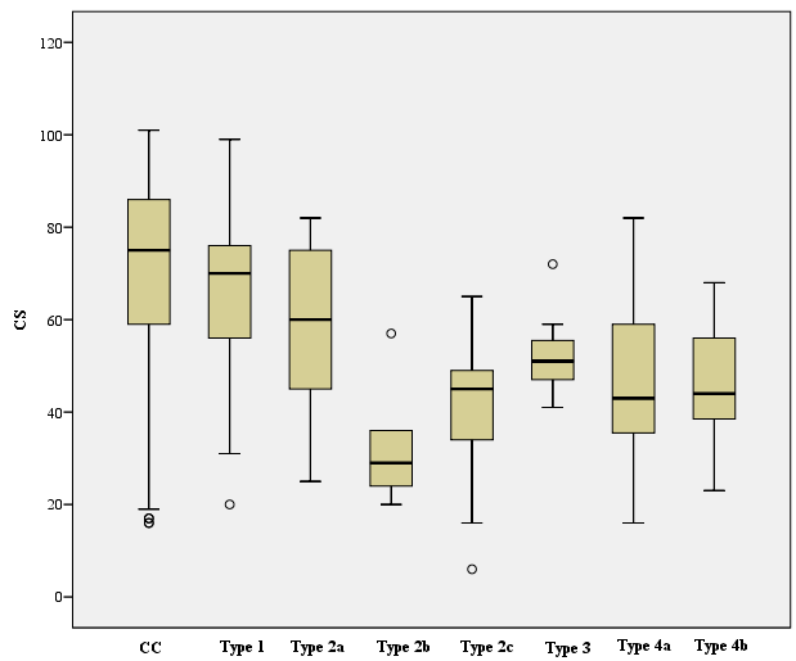
Figure 22. Comparison CS of collective without complications and complication types (X-axis: study collective, Y-axis: median, IQR, extreme values, outliers).